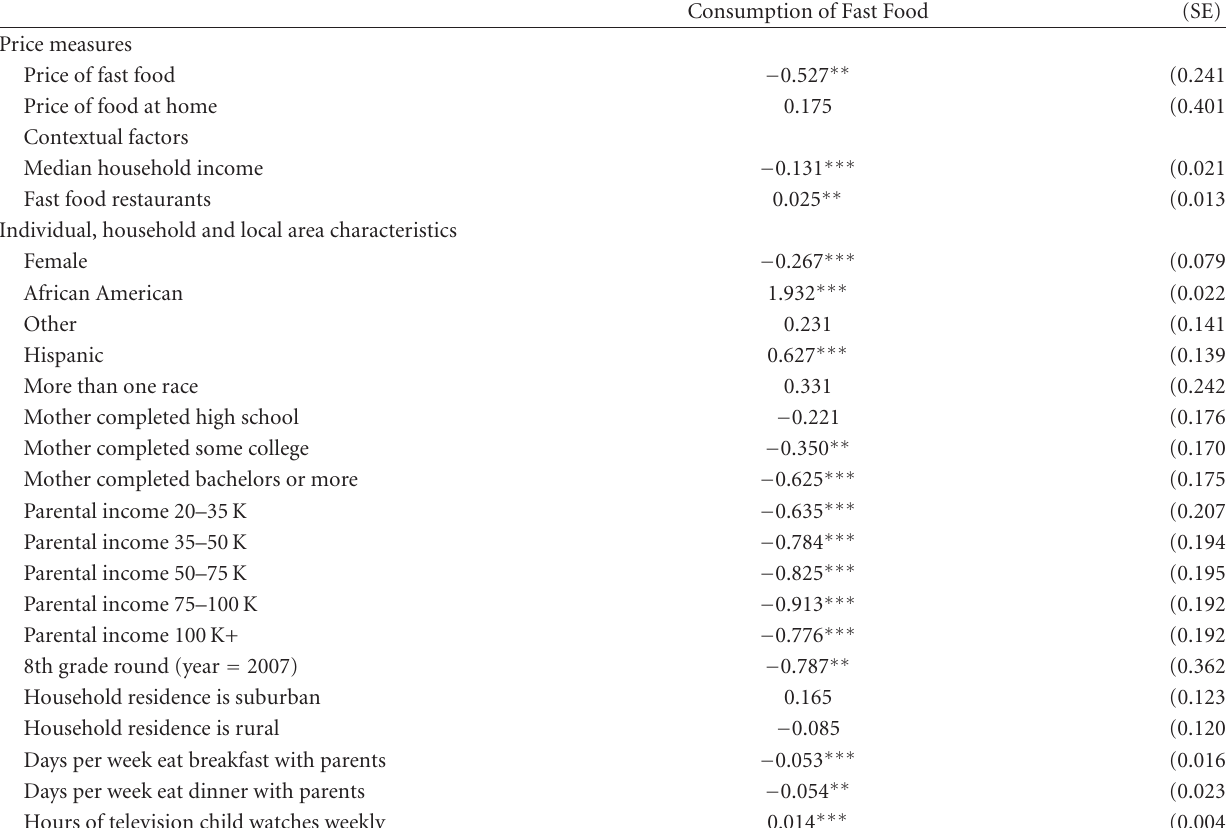
Table 2: Longitudinal regression estimates for individual level random e ff ects model of the determinants of fast food consumption.